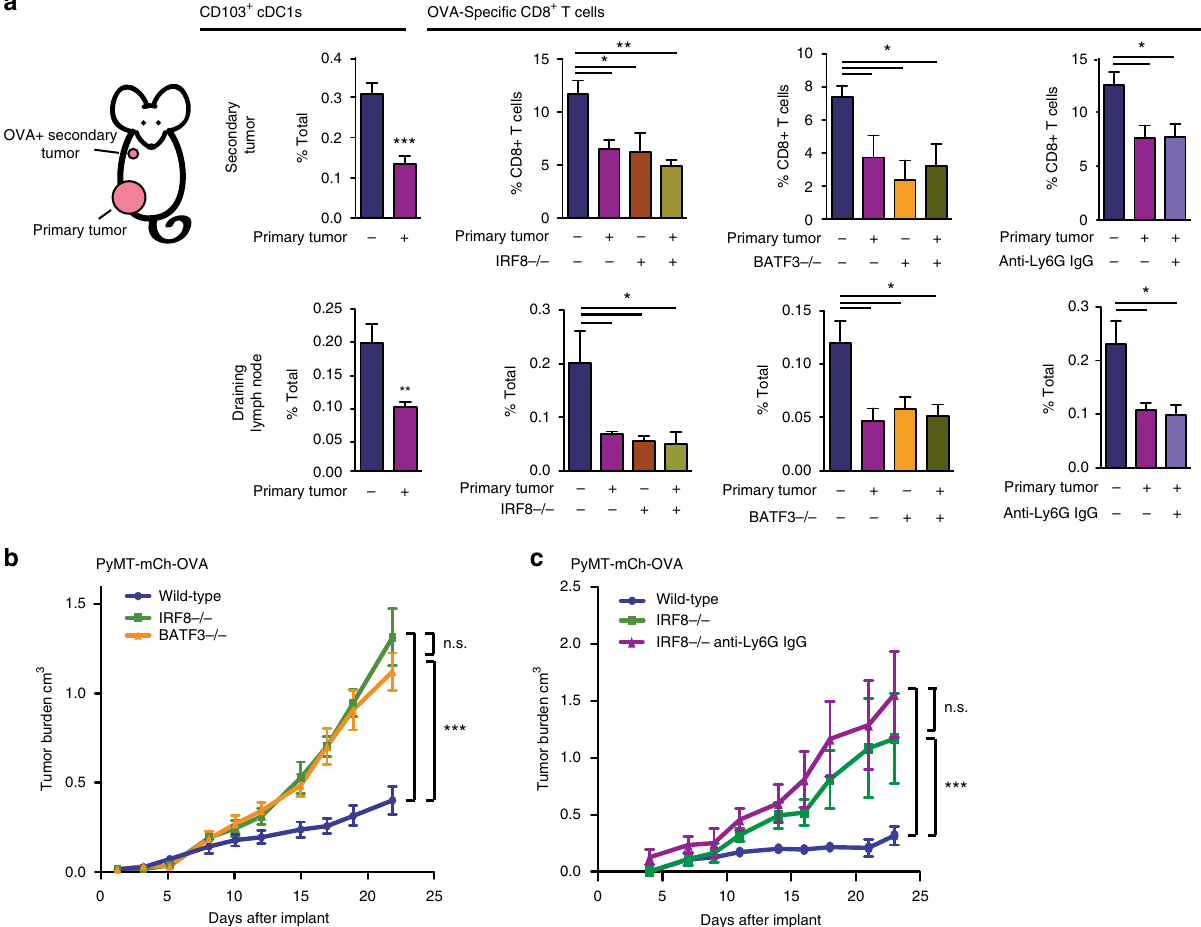
Fig. 8 IRF8 and cDC1s are necessary for anti-tumor CD8 + T-cell responses. a Mice with 1.0 cm diameter orthotopic PyMT-B6 tumors and tumor-free controls were implanted with PyMT-B6-mCh-OVA cells in the upper mammary fat pad. After 7 days, the secondary tumor and its draining LN were analyzed for frequency of CD103 + cDC1s and OVA-speci fi c CD8 + T cells. OVA-speci fi c T-cell analysis was also performed in age-matched IRF8 − / − and Batf3 − / − mice and mice treated with anti-Ly6G IgGs starting 1 day before implant of upper mammary fat pad tumor; n = 5 mice/group. Experimental replicates are displayed. b Tumor volume over time in Batf3 − / − , IRF8 − / − , and wild-type controls implanted with orthotopic PyMT-B6-mCh-OVA tumors; wild-type, n = 10 ; BATF3 − / − , n = 7; IRF8 − / − n = 4. Data are representatives of two individual experiments. c Tumor volume over time in IRF8 − / − , IRF8 − / − treated with anti-Ly6G IgGs starting 1 day prior to implant and wild-type controls implanted with orthotopic PyMT-B6-mCh-OVA tumors; wild type, n = 6; IRF8 − / − , n = 3; IRF8 − / − treated with anti-Ly6G IgGs, n = 3. Error bars represent mean + / − s.e.m.; * p < 0.05, ** p < 0.01, *** p < 0.001, n.s., not signi fi cant by unpaired two-sided Student ’ s t test or two-way